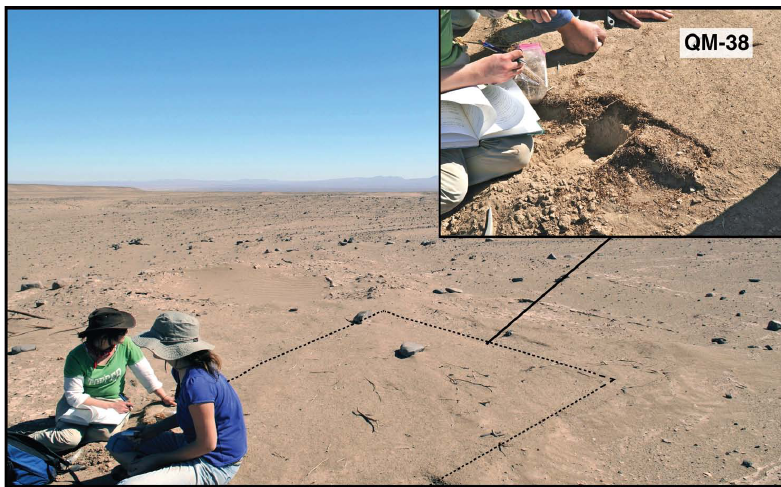
Fig. A8. QM-28 polygonal shaped leaf-bed (dotted line). Details for superficial Prosopis leaves are